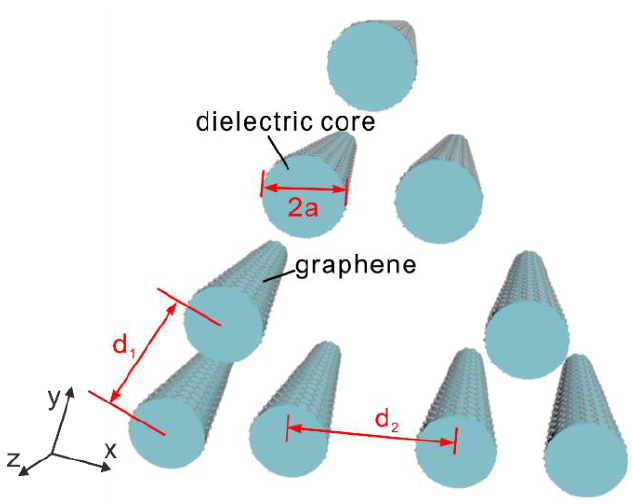
Figure 1. Geometry of the proposed triangular nanowire waveguide.